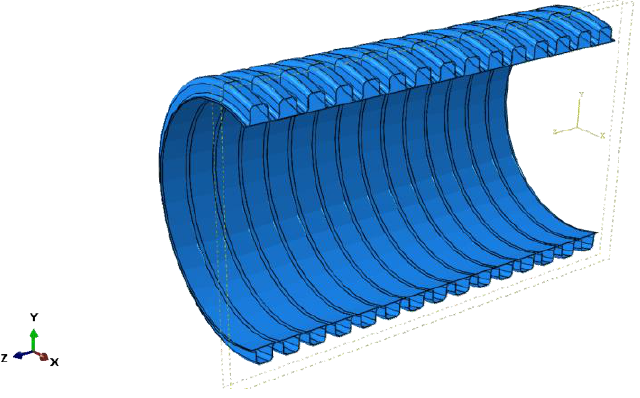
Figure 1. Schematic diagram of cross section of double-wall corrugated pipe.